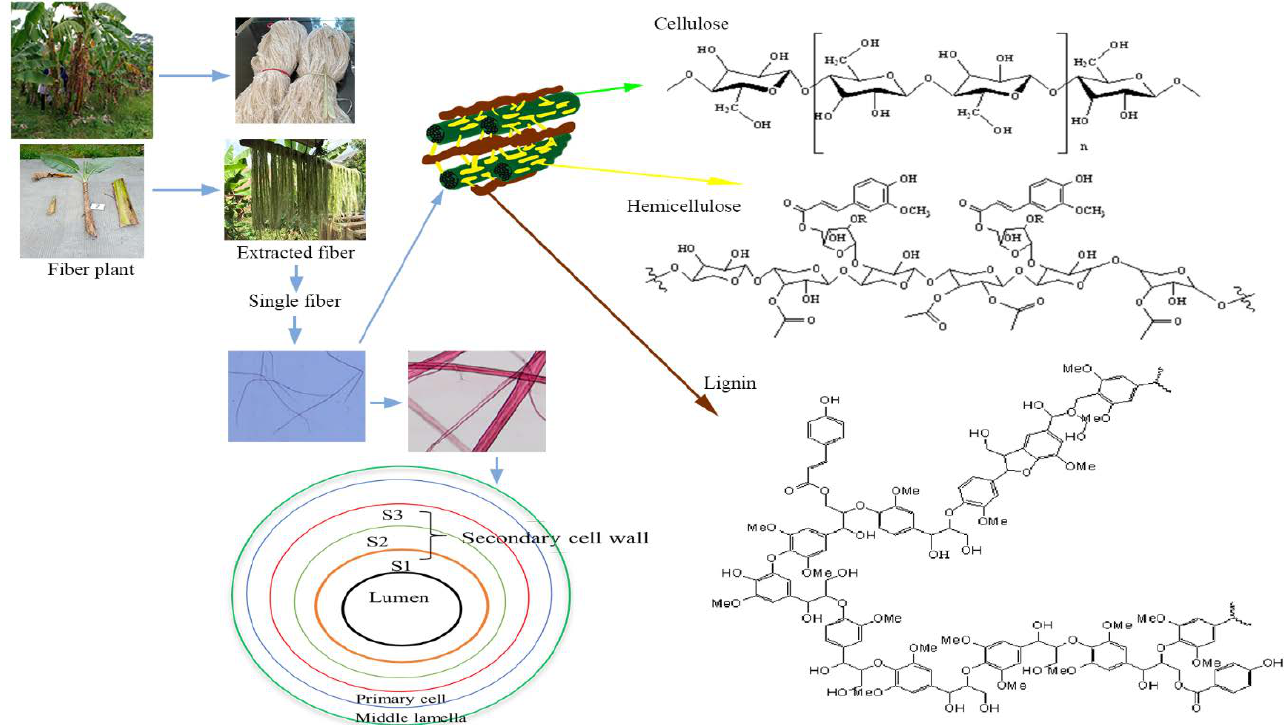
Figure 3. The hierarchical cell wall structure of lignocellulosic biomass (adapted from [134], Copyright © 2021 Elsevier Inc., License Number: 5193031271486) Cell wall layer position of plants (modified from [135], Copyright © 2021 Elsevier Ltd., License Number: 5193040344374).